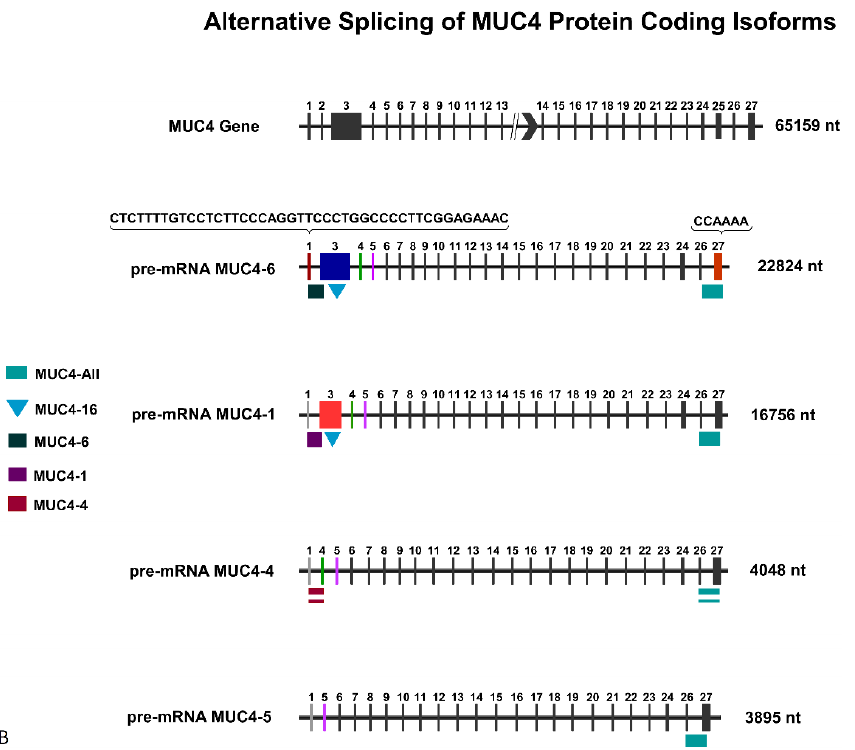
Figure 4. Sequence similarity analyses for MUC4 . ( A ): The sequence similarity of the four alterna- tively spliced isoforms of MUC4 . ( B ): Illustration of the exon organization of MUC4 used to design primers for the specific amplification of alternatively spliced isoforms. The MUC4 gene and isoforms are presented as horizontal lines. Each vertical bar represents an exon separated by intronic regions.